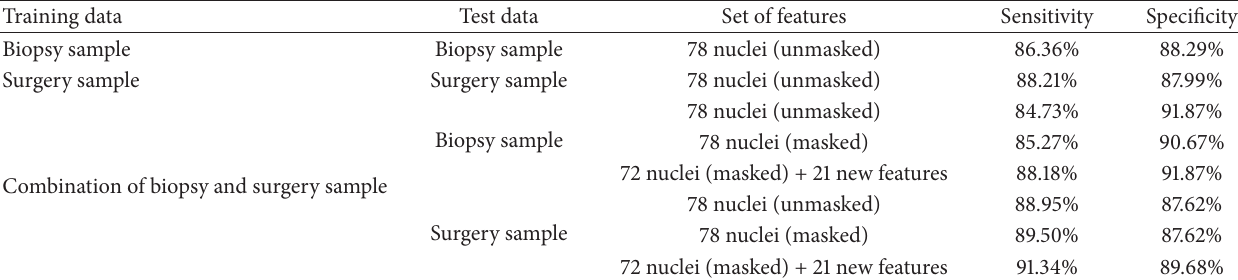
Table 1: Experiment